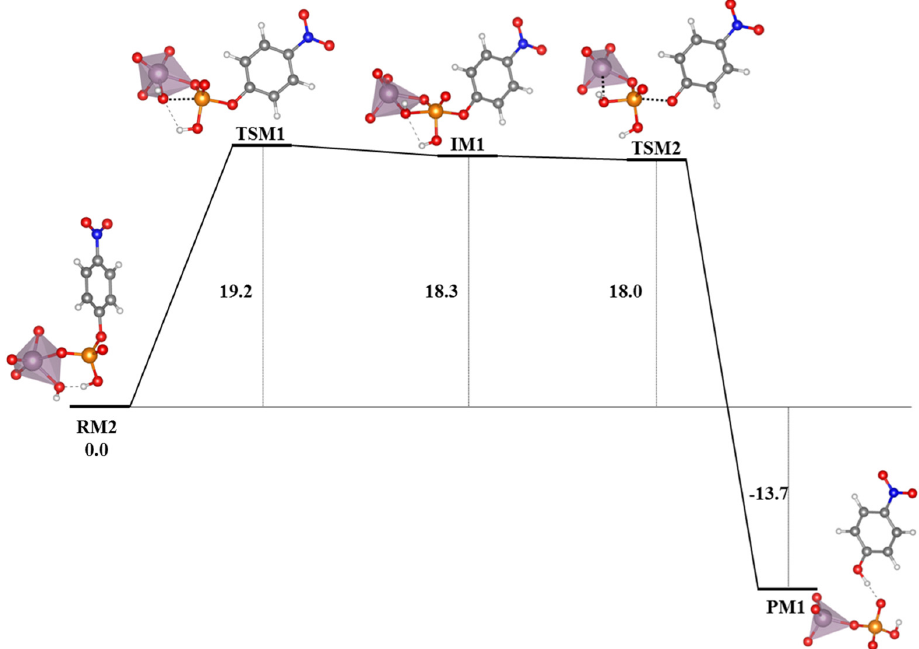
Figure 40. Computed Gibbs free energy profile for the pNPP hydrolysis by considering mononuclear molybdenum species at B3LYP/6-311++G(3df,2p)//B3LYP/6-31+G** level by using solvent effects with the PCM approach. The relative Gibbs free energies are in kcal mol − 1 .